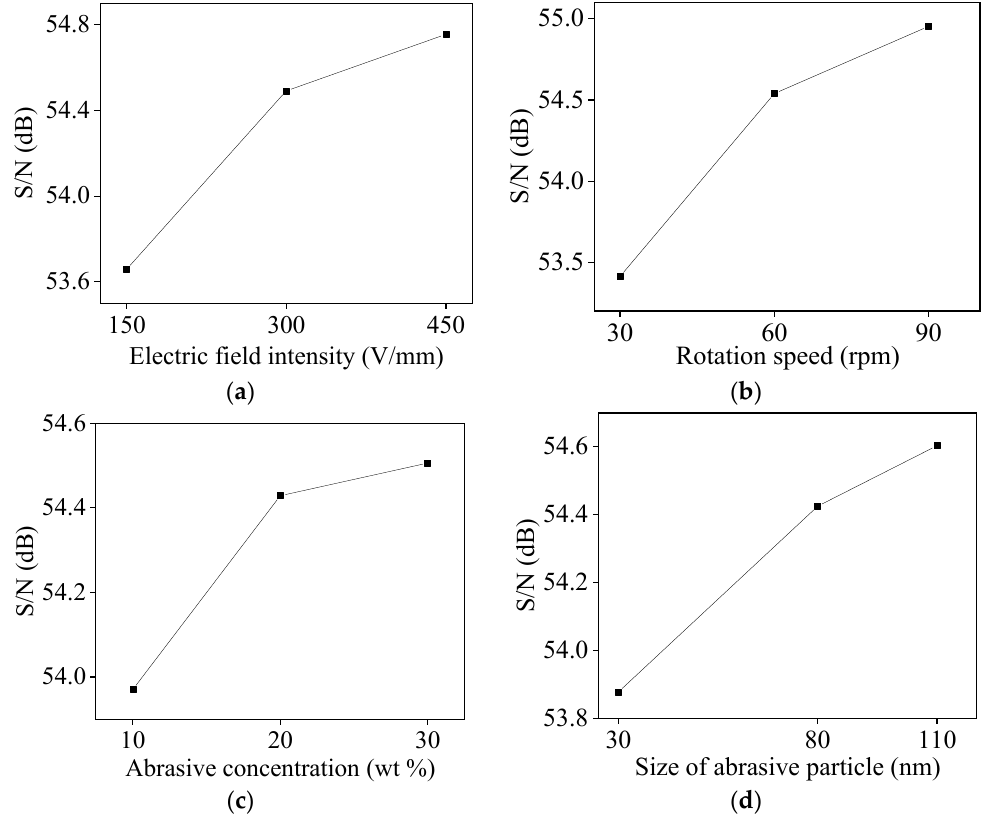
Figure 4. Influence of process parameter level on material removal rate (S/N average response): ( a ) electric field intensity; ( b ) rotation speed; ( c ) abrasive concentration; ( d ) size of abrasive particle.